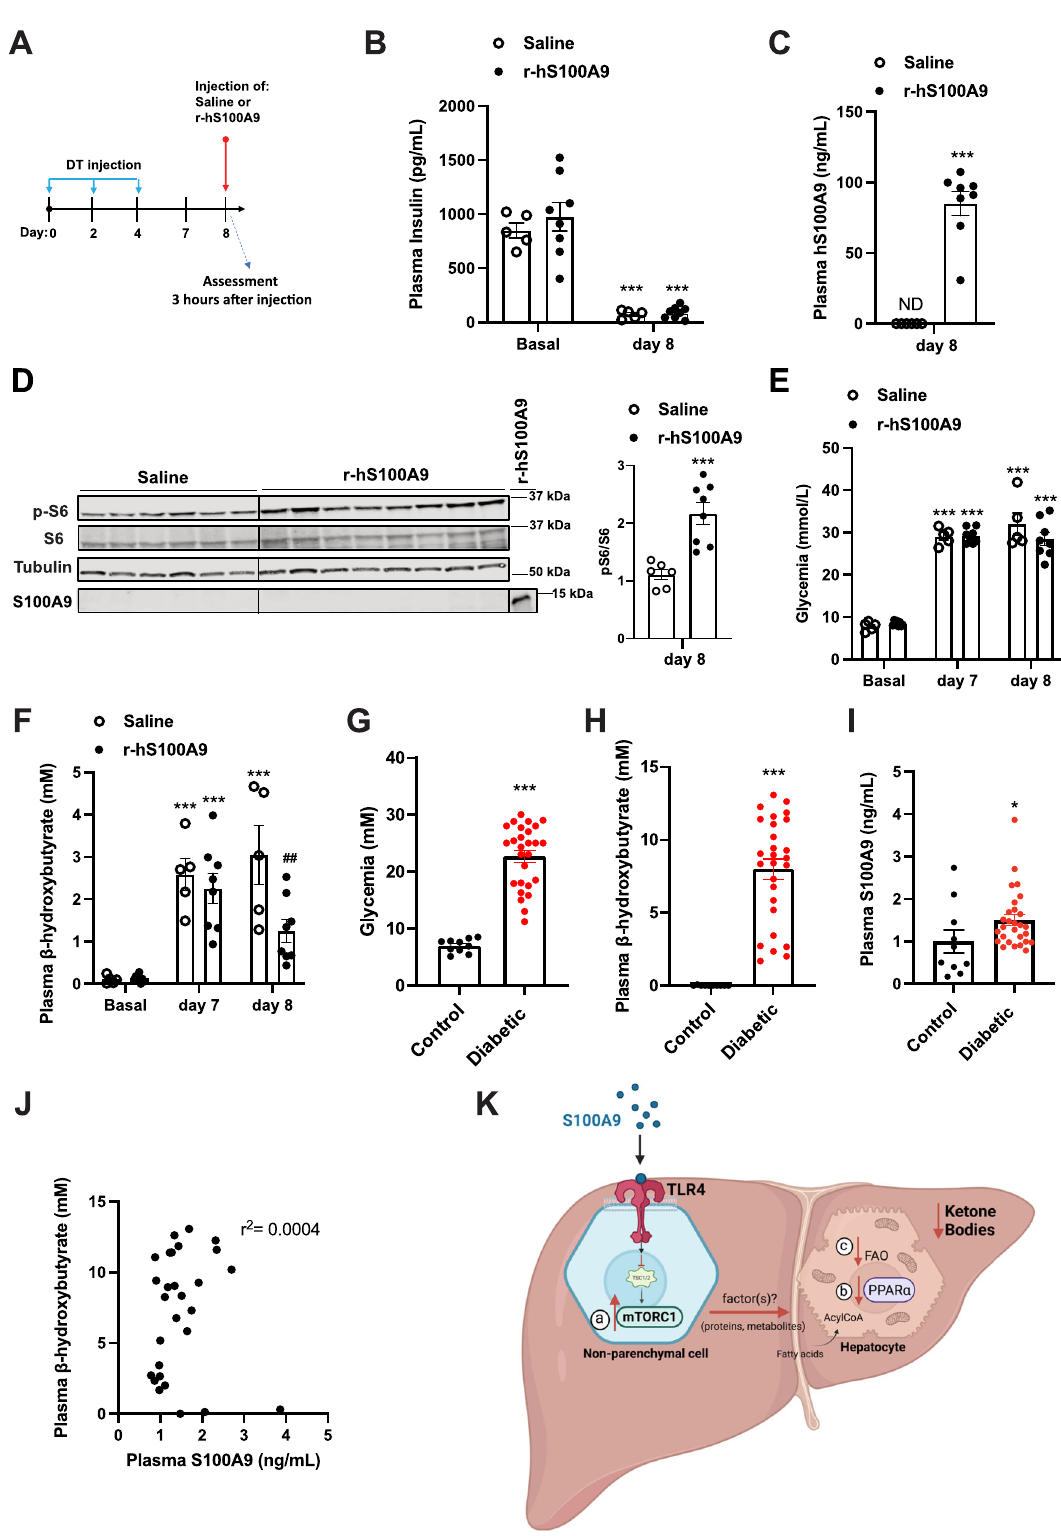
approach aimed at achieving better metabolic control in patients with diabetes suffering from ID. As indicated in Fig. 7K and based on our results, we propose a model in which administration of human recombinant S100A9 acts on TLR4 in the liver to trigger the mTORC1 axis which, in part via suppression of PPAR α , leads to reduced hepatic fatty acid oxidation (FAO) and ketogenesis in an insulin-independent fashion in patients suffering from ID.